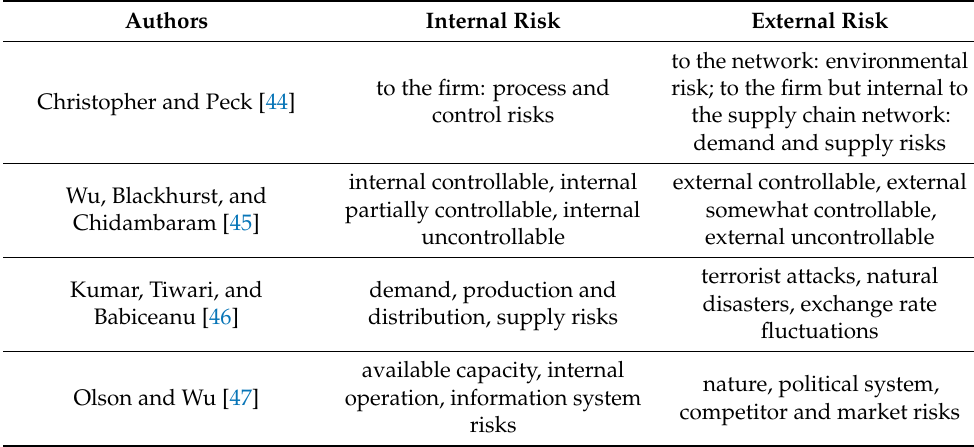
Table 2. Examples of the risk